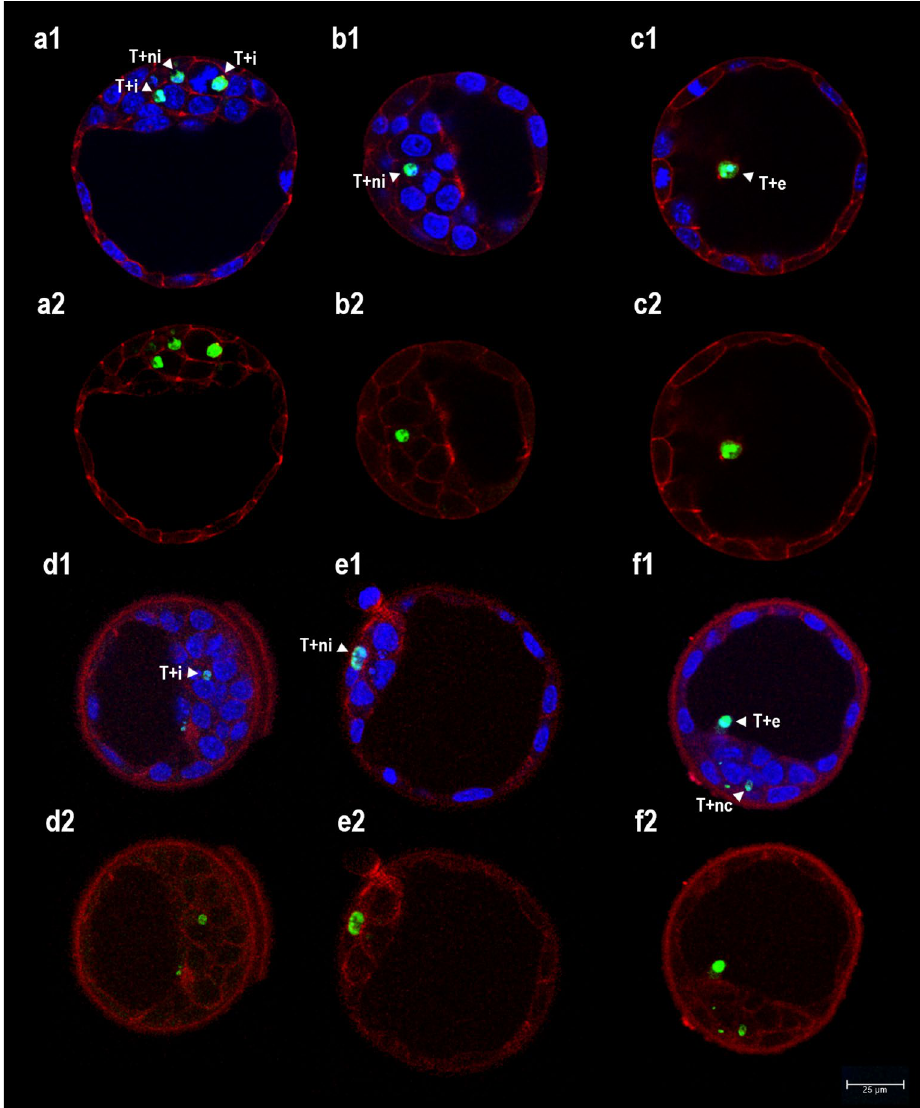
Figure 2. Analysis of apoptotic cell internalization in mouse blastocysts. Images were obtained by confocal laser scanning microscopy (magnification × 400). Single optical sections of six blastocysts are shown in pictures ( a–f ). ( a–c ) fluorescence staining of F-actin in plasma membrane (red) combined with TUNEL labelling (T + = green) and Hoechst 33342 DNA staining (blue) ( a1 – c1 : merge); ( d – f ) immunochemical staining of E-cadherin in plasma membrane (red) combined with TUNEL labelling (T + = green) and Hoechst 33342 DNA staining (blue) ( d1 – f1 : merge). Abbreviations: i, internalized apoptotic nuclei (T + nuclei in embryonic cells with a normal nucleus and intact plasma membrane); ni, non-internalized apoptotic nuclei (T + nuclei surrounded by the intact plasma membranes of at least three neighbouring cells); e, extruded apoptotic nuclei (in blastocoele); nc, non-classified apoptotic nuclei (dubious